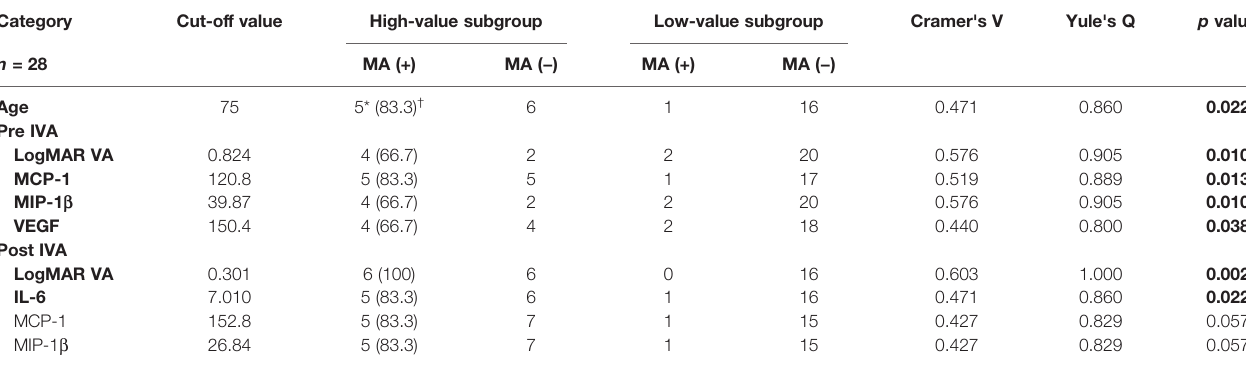
TABLE 4 | Relationship between incidence of macular atrophy and age, visual acuity, or aqueous humor cytokine levels in nAMD eyes under a fl ibercept treatment. Category Cut-off